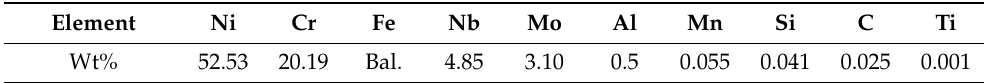
Figure 1. Various magnifications of an IN718 powder image from a scanning electron microscope (SEM). Table 1. The IN718 powder’s chemical make-up.